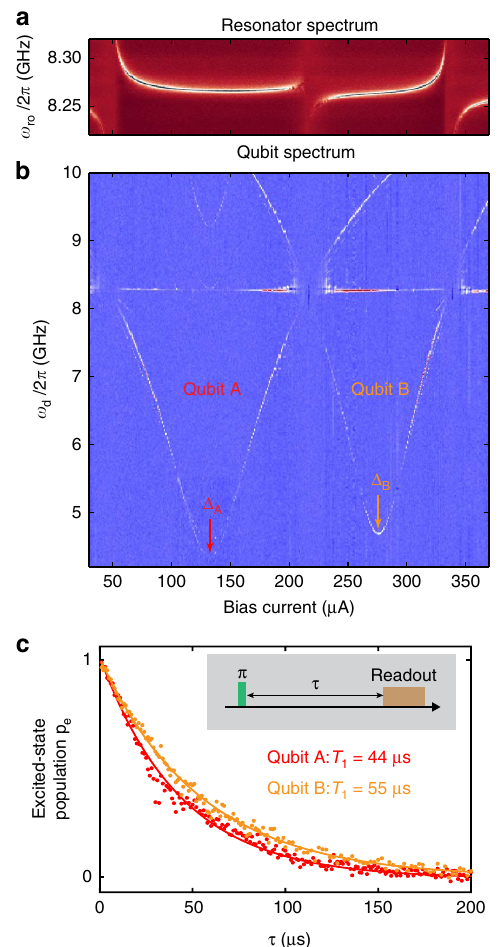
Figure 2 | Spectroscopy and T 1 of two capacitively shunted flux qubits. ( a , b ) Resonator and qubit spectra versus bias current used to induce the global magnetic field B . The qubit transition frequencies o q /2 p have minima D A /2 p ¼ 4.36GHz and D B /2 p ¼ 4.70GHz at the qubit flux- insensitive points, which are intentionally offset in bias current (magnetic flux) by using different qubit-loop areas. ( c ) Energy-decay functions of qubits A and B measured at their respective degeneracy points using the inversion-recovery pulse sequence (inset). Solid lines are exponential fits with decay constant T 1